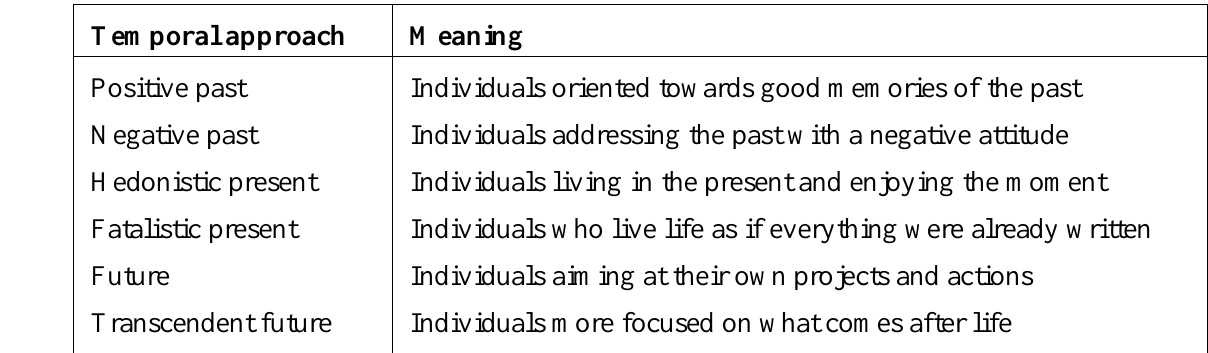
Table 3: Psychological theory of the Temporal Approach.